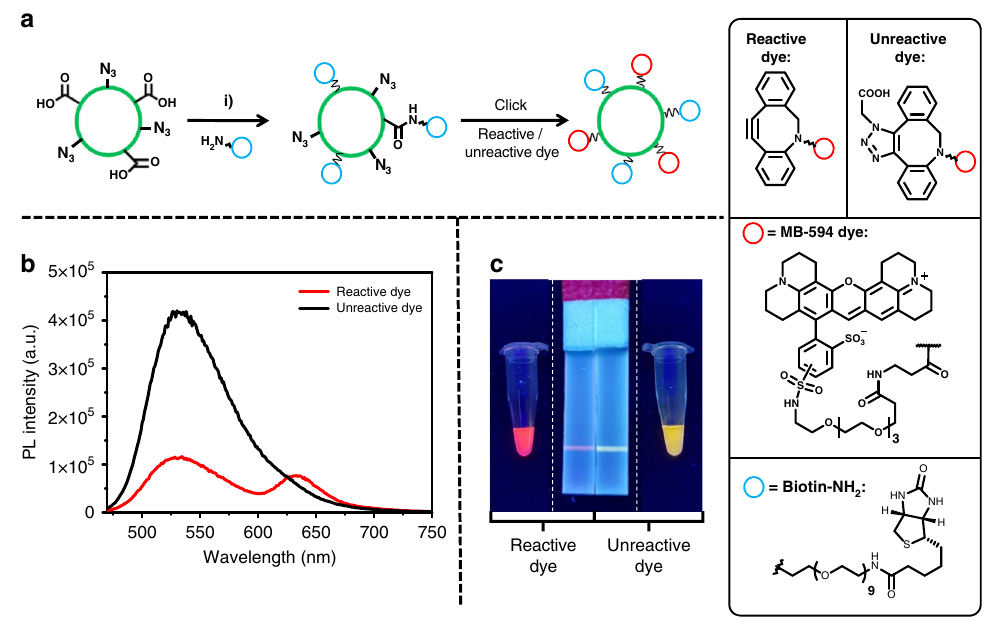
Fig. 6 SPN surface bifunctionalisation. a Schematic of the modi fi cation of the surface of SPN-multi-nanoparticles with biotin followed by DBCO-594, (i) 1- ethyl-3-(3-dimethylaminopropyl)carbodiimide (EDC) and N -hydroxysulfosuccinimide (sulfo-NHS). b PL spectra of the nanoparticle solutions with reactive and unreactive dye (red and black lines, respectively). Samples were pulsed at 450 nm, with 10 vol% THF added. c Images of lateral fl ow strips run with unreactive and reactive dye nanoparticle solutions alongside the solutions (with 10 vol% THF added) all irradiated with UV light (365